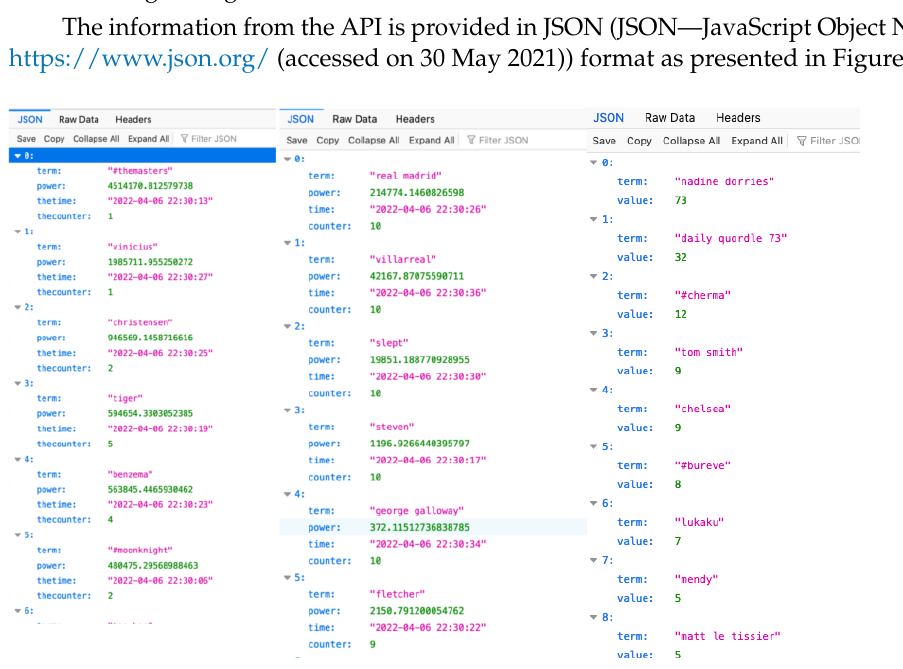
Figure 5. Sample results from JSON data execution.